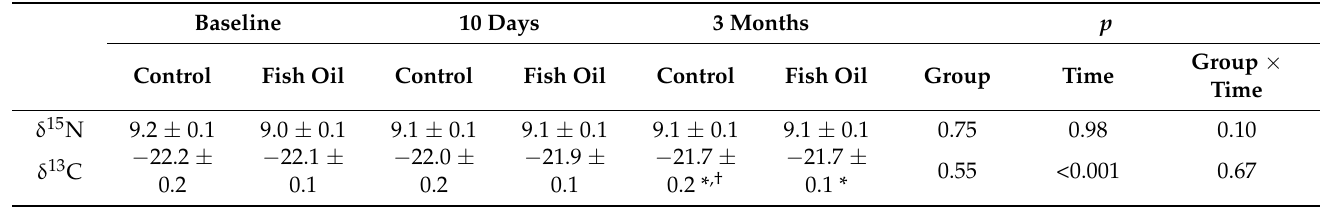
Table 3. Plasma δ 15 N and δ 13 C in a subsample of advanced breast cancer patients who complied with fish oil supplementation ( n = 10) or with a control supplementation ( n = 9).